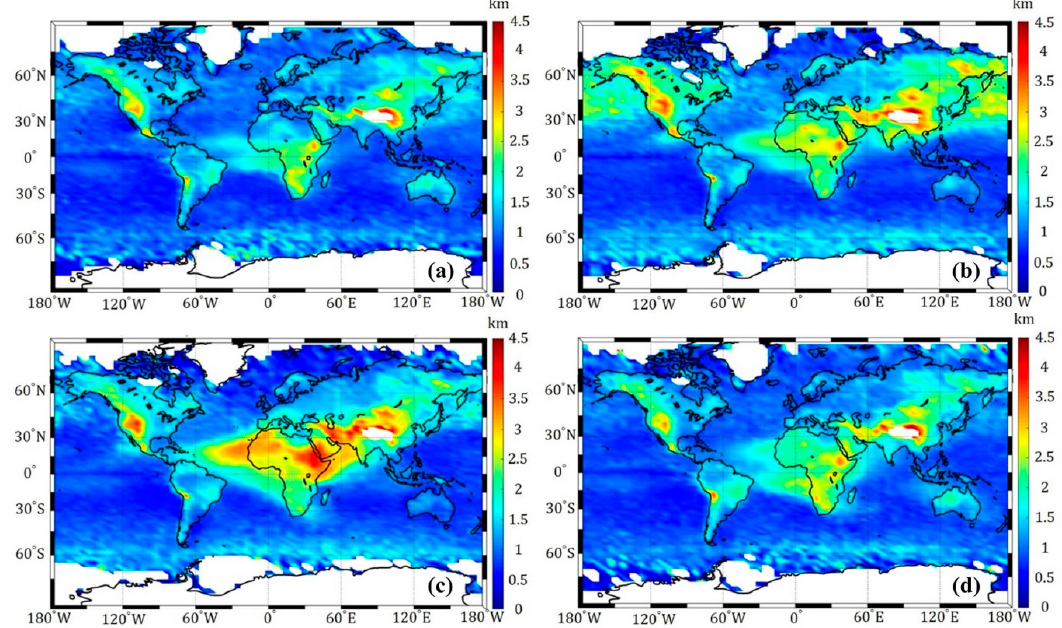
Figure 3. Same as Figure 2 but for the dust aerosol MFA.